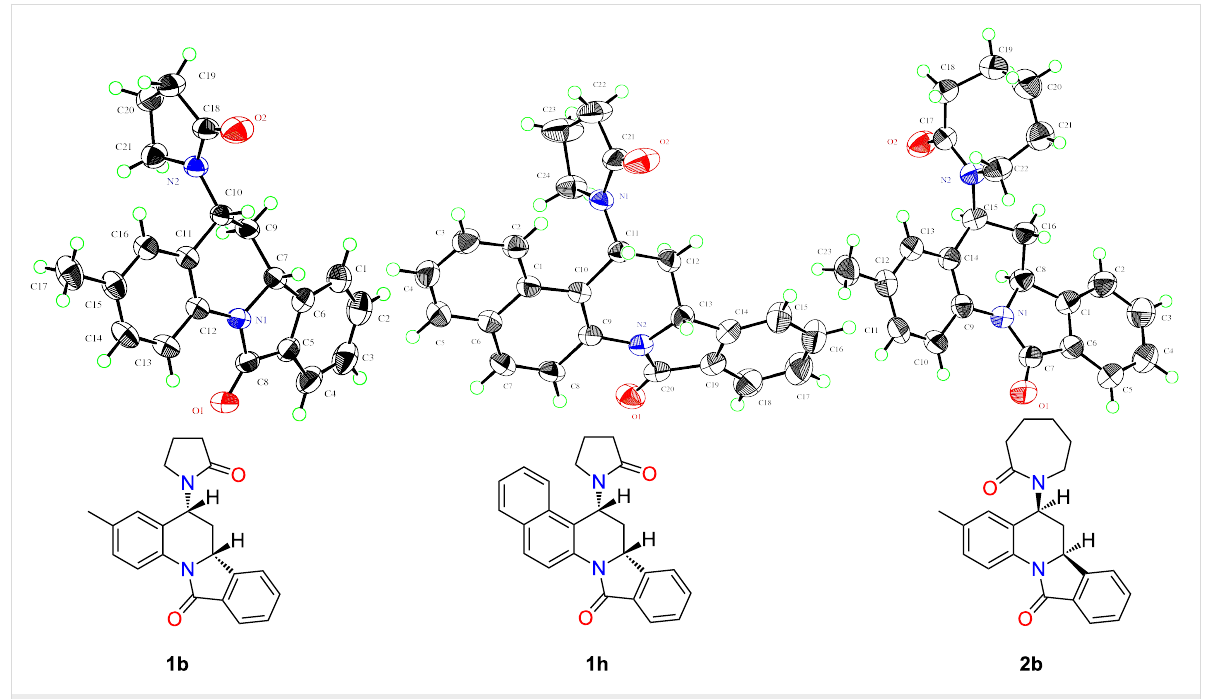
Figure 2: ORTEP diagrams and 2D structures for the isoindolo[2,1- a ]quinolone derivatives 1b , 1h and 2b .